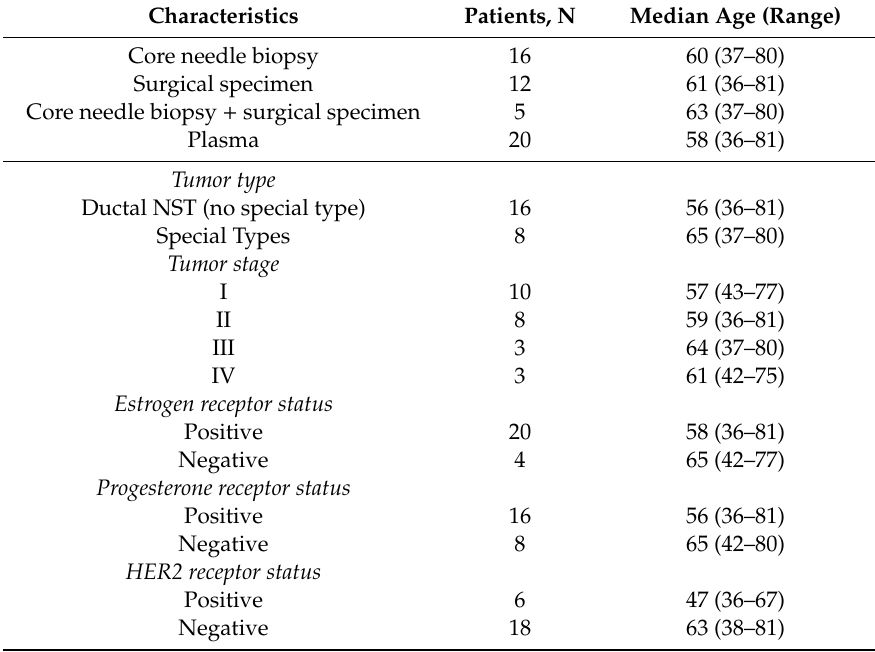
Table 3. Clinicopathologic characteristics of women with breast